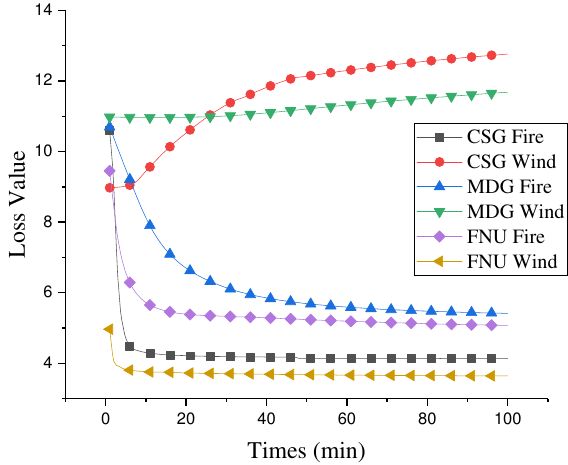
Figure 8. Loss value for training 3 LSTM-based